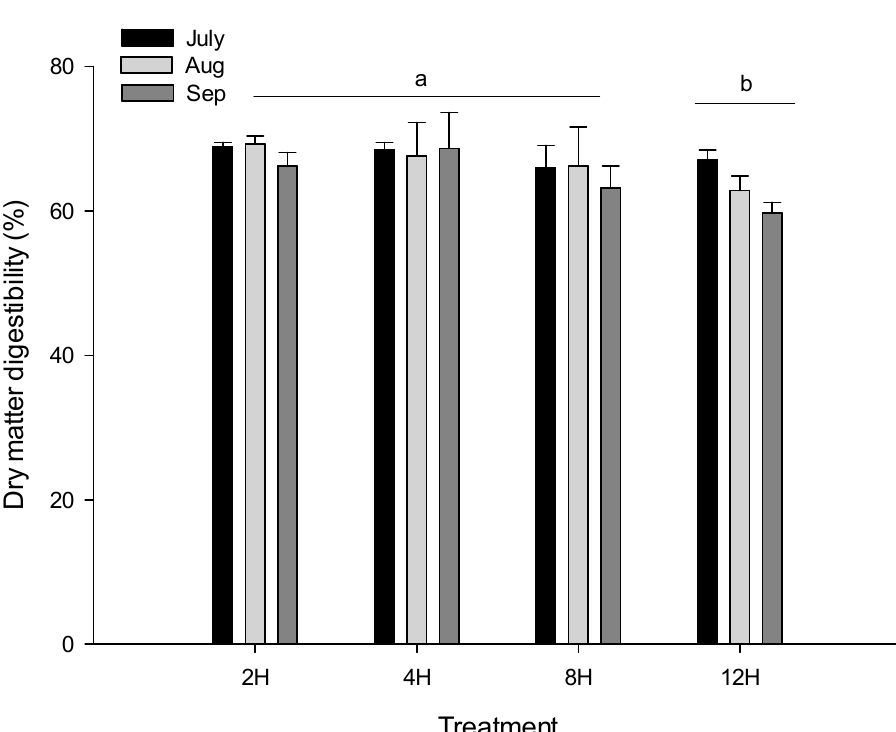
Figure 1. Dry matter digestibility by lambs in each treatment group. Treatments: 2H = 2 h access to pasture; 4H = 4 h access to pasture; 8H = 8 h access to pasture; 12H = 12 h access to pasture. The a and b mean there was significant difference ( p < 0.05) among treatments.